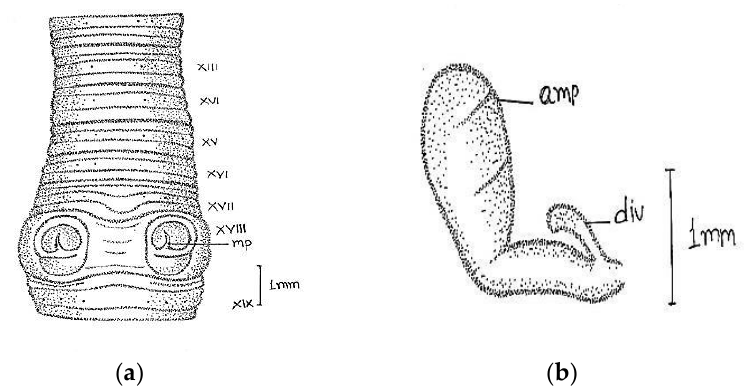
Figure 9. Camera lucida illustration of Megascolex travancorensis travancorensis ( a ) genital region; ( b ) spermathecae.